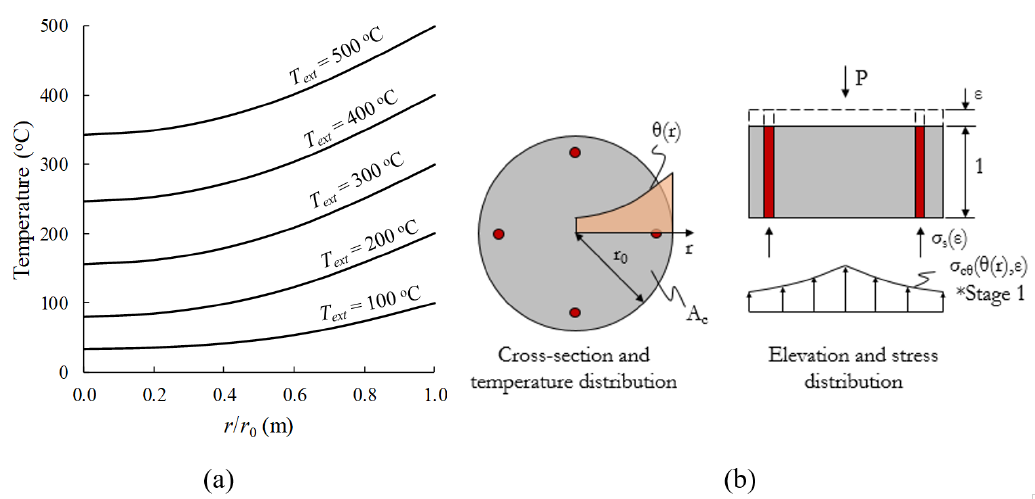
Figure 10. Theoretical model: a) temperature distribution with the relative distance between center and outer face ( r / r 0 ); b) stress distribution as a function of specific strain and temperature